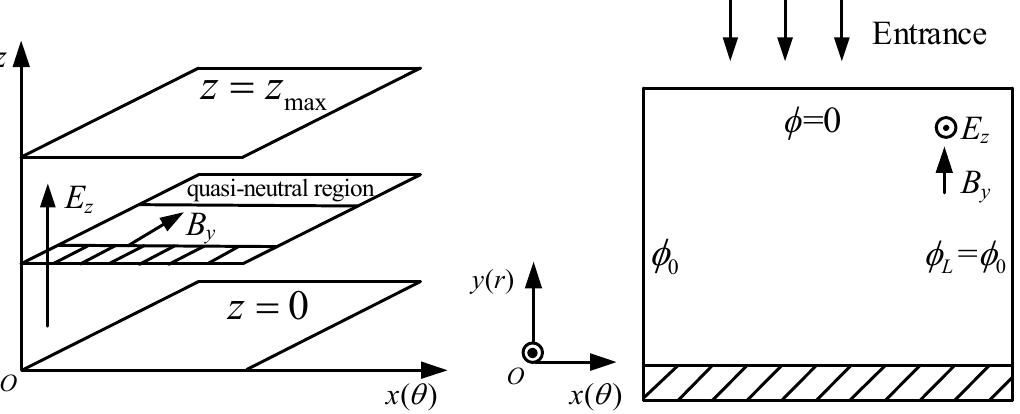
Figure 2. Geometry structure of the PIC model in azimuthal-radial plane.